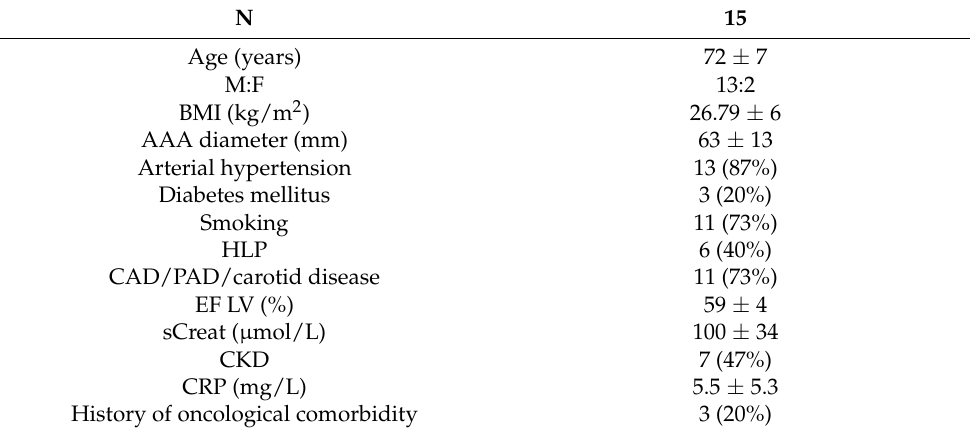
Table 1. Patient